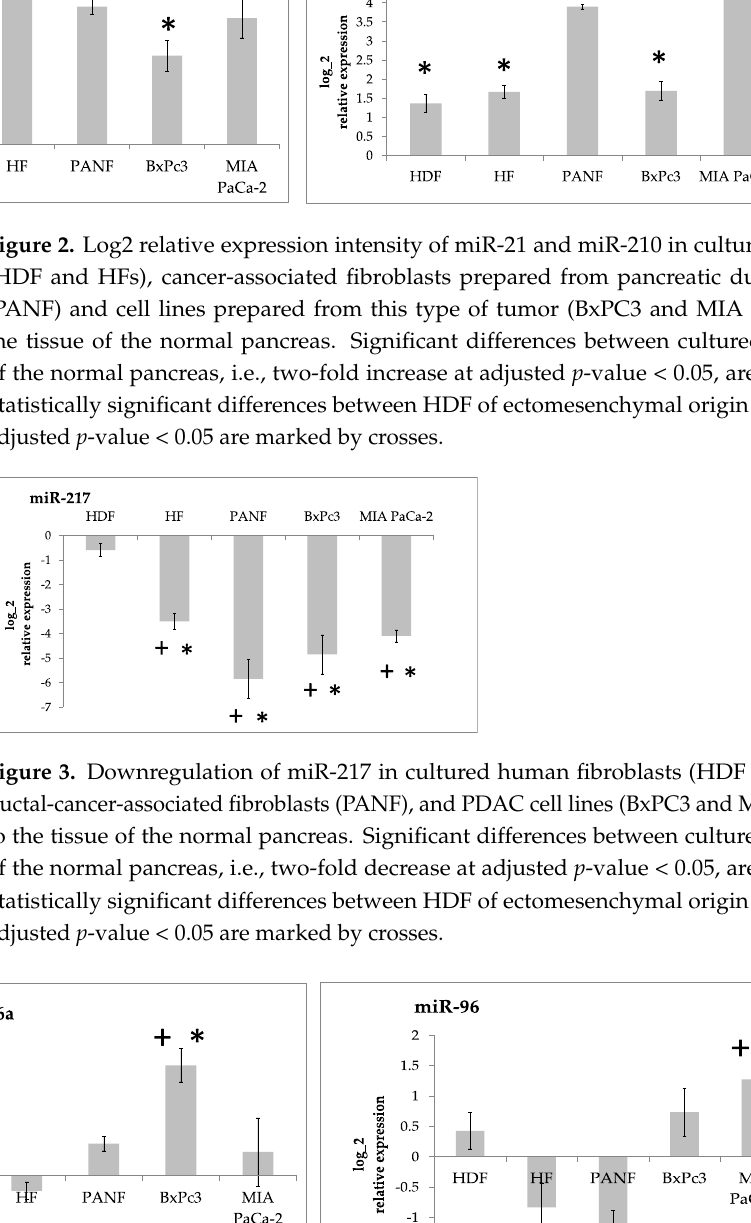
Figure 3. Downregulation of miR-217 in cultured human fibroblasts (HDF and HFs), pancreatic- ductal-cancer-associated fibroblasts (PANF), and PDAC cell lines (BxPC3 and MIA PaCa-2) com- pared to the tissue of the normal pancreas. Significant differences between cultured cells and the tissue of the normal pancreas, i.e., two-fold decrease at adjusted p -value < 0.05, are marked by Figure 4. Log2 relative expression intensity of miR-196a and mir-96 in cultured human fibroblasts (HDF and HFs), cancer-associated fibroblasts prepared from pancreatic ductal adenocarcinoma (PANF), and cell lines prepared from this type of tumor (BxPC3 and MIA PaCa-2) compared to the tissue of the normal pancreas. Biologically significant differences between cultured cells and the tissue of the normal pancreas (two-fold change with adjusted p -value < 0.05) are marked by asterisks. Statistically significant differences between HDF and other cell lines at adjusted p -value < 0.05 are marked by crosses.